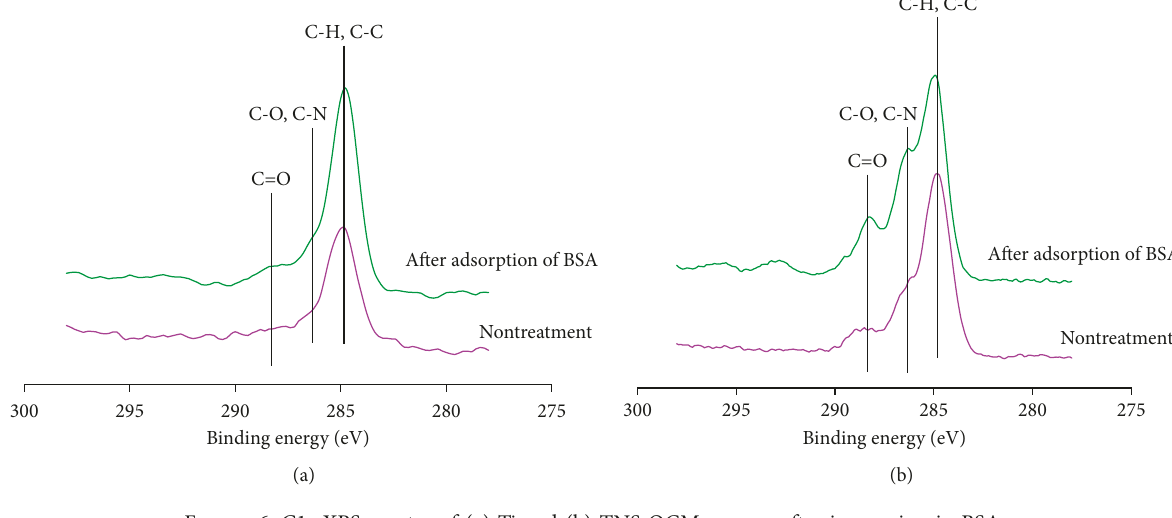
Figure 6: C1s XPS spectra of (a) Ti and (b) TNS QCM sensors after immersion in BSA.